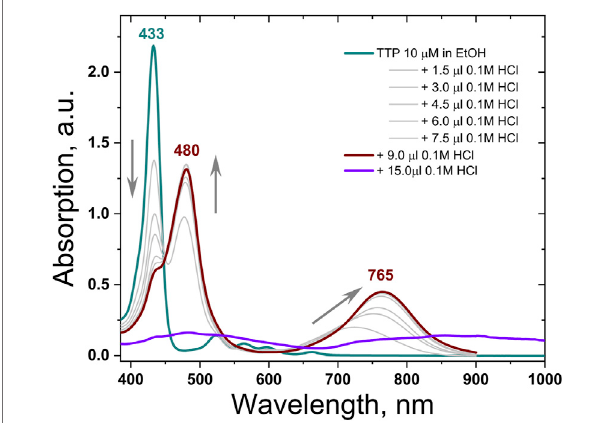
FIGURE2| AbsorptionspectraofTTPinethanolneat(thedarkcyanline) andinthepresenceof3×10 – 4 MHCl(thewineline)andinthepresenceof5× 10 – 3 M HCl (the violet line). For clarity, all intermediate absorption spectra are in light